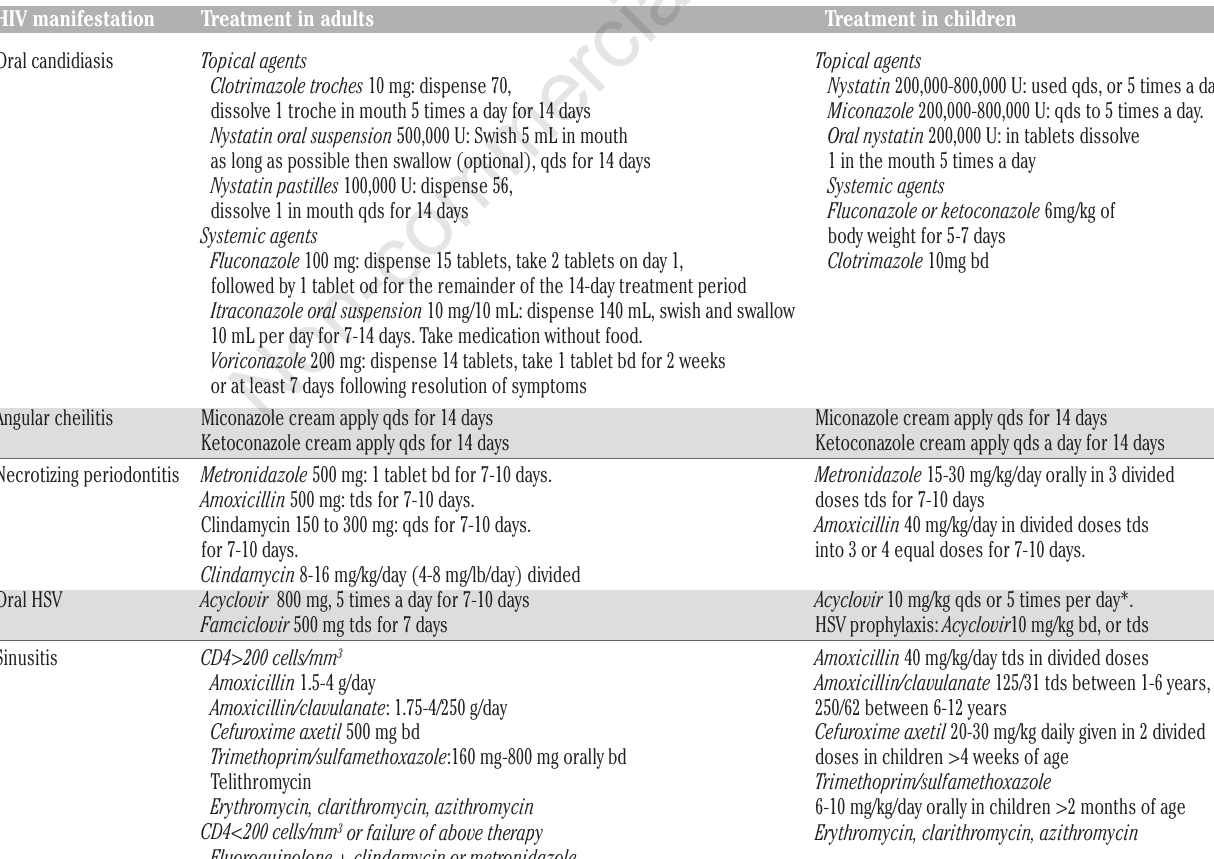
Table 1. Treatment regimens for HIV-associated ear, nose and throat (ENT) manifestations in adults and children. HIV manifestation